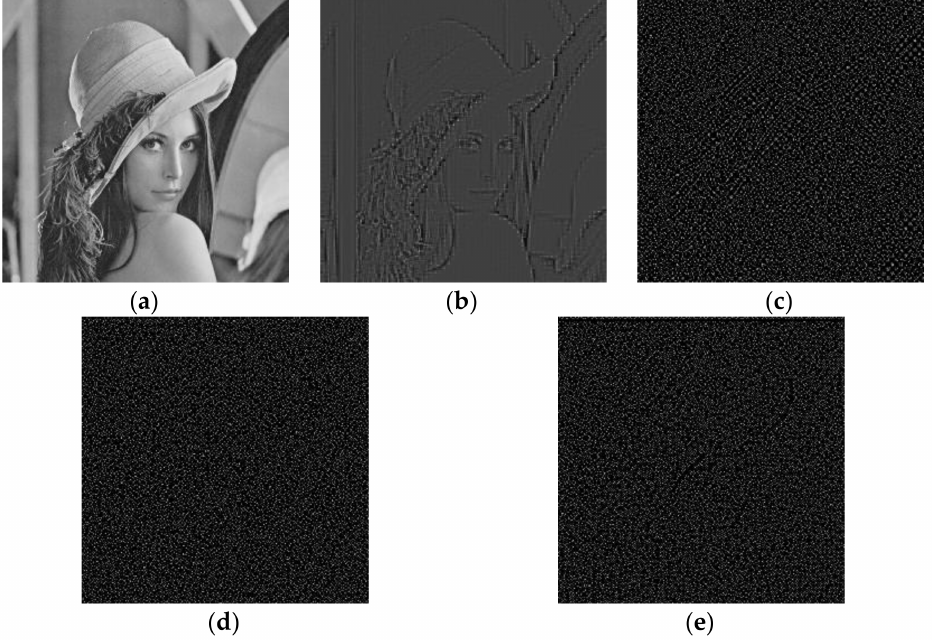
Figure 1. The residual images formed by sub-images: ( a ) Original Lena image; ( b ) residual image formed by u 1 v T ; ( c ) residual image formed by u 2 v T 1 image formed by u 4 v T 4